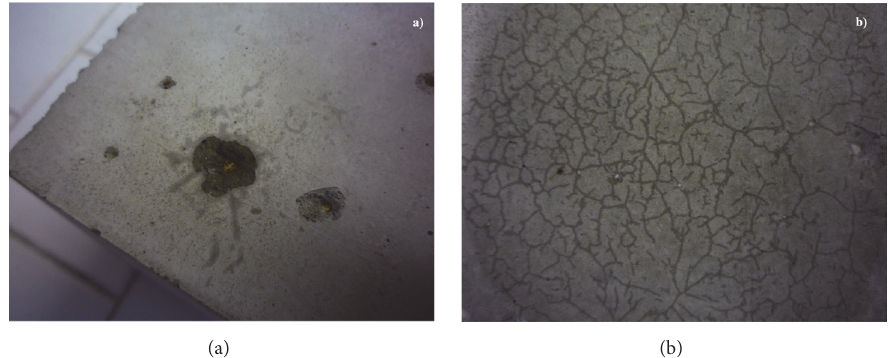
Figure 3: Image of the surface of the reference mortar sample after 1 year of ageing in water: (a) spalling; (b) chipping.